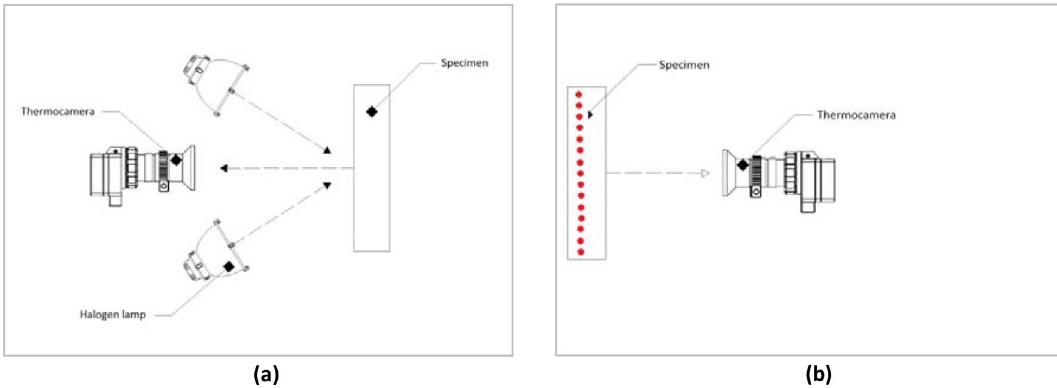
Fig. 1 Schematics of traditional active thermography ( a ) and material enabled thermography ( b )